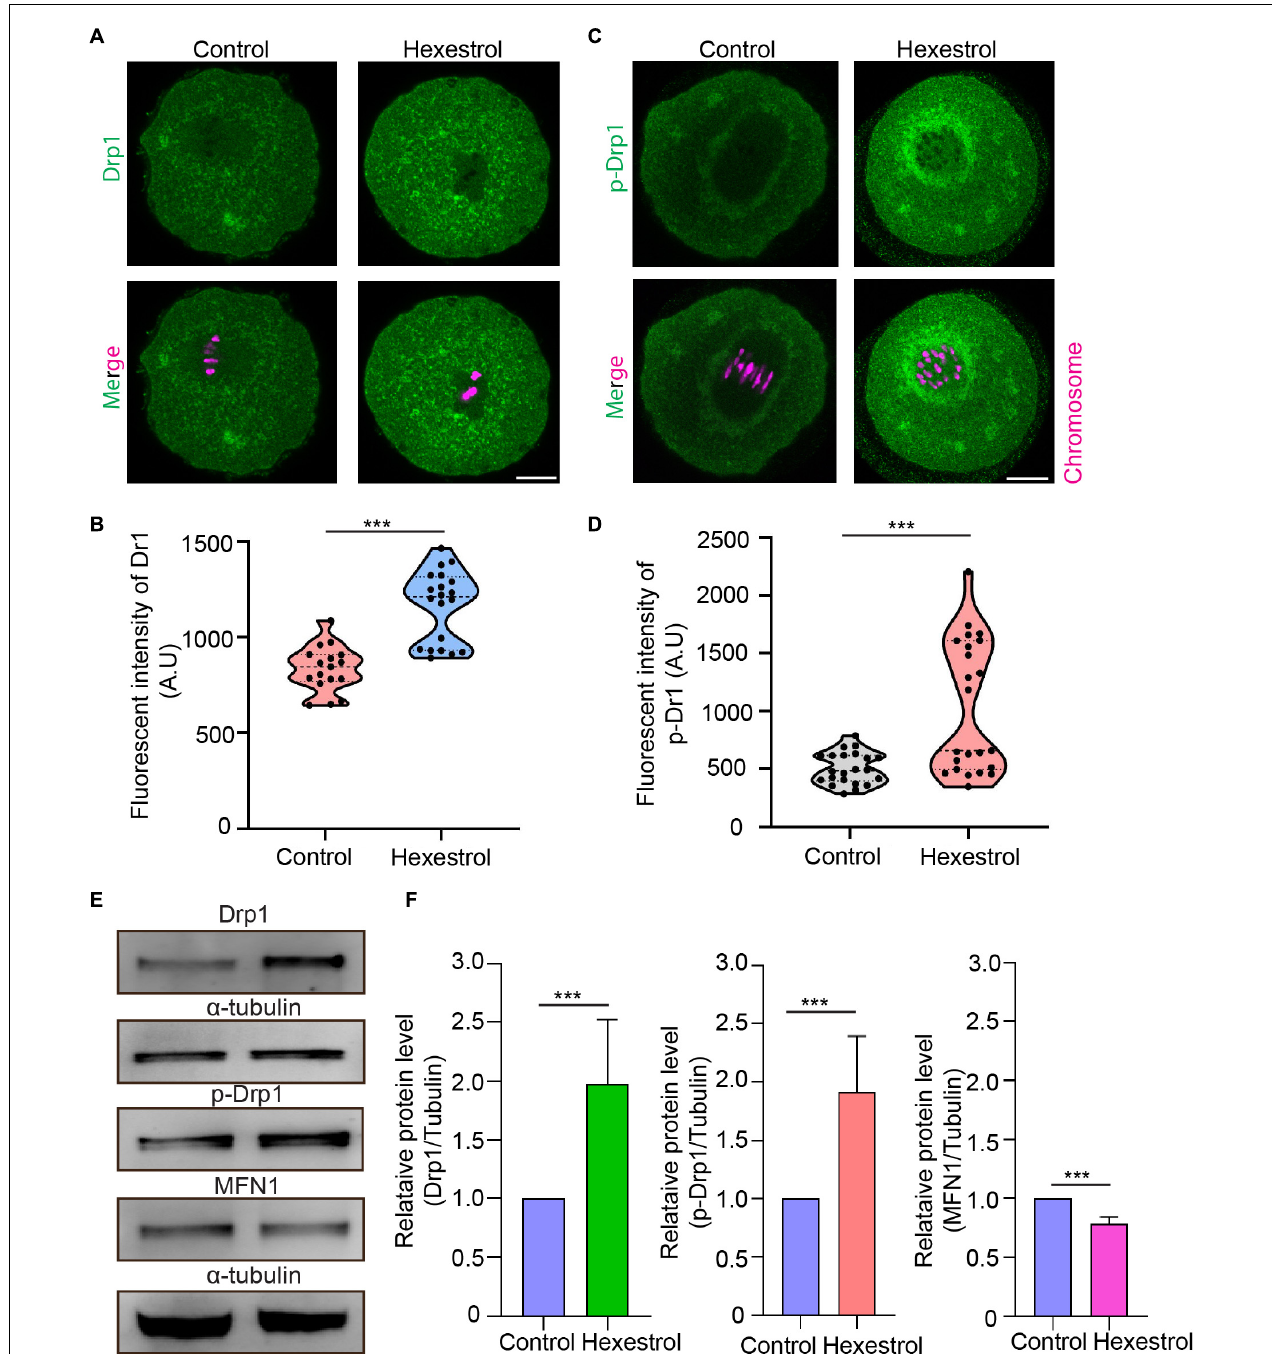
FIGURE 5 | HES perturbs mitochondrial fission and fusion process in oocytes. (A) Representative images of Drp1 localization in control and HES-exposed oocytes. Scale bar, 20 µ m. (B) Fluorescent intensity of Drp1 was quantified after HES exposure. *** P < 0.001. (C) Representative images of phosphorylated-Drp1 localization in control and HES-exposed oocytes. Scale bar, 20 µ m. (D) Fluorescent intensity of p-Drp1 was recorded after HES exposure. *** P < 0.001. (E) Drp1, p-Drp1, and MFN1 protein levels were examined by using Western blot. Data are represented as mean ± SD from at least three independent experiments. (F) The protein levels of Drp1, p-Drp1, and MFN1 were quantified by Image